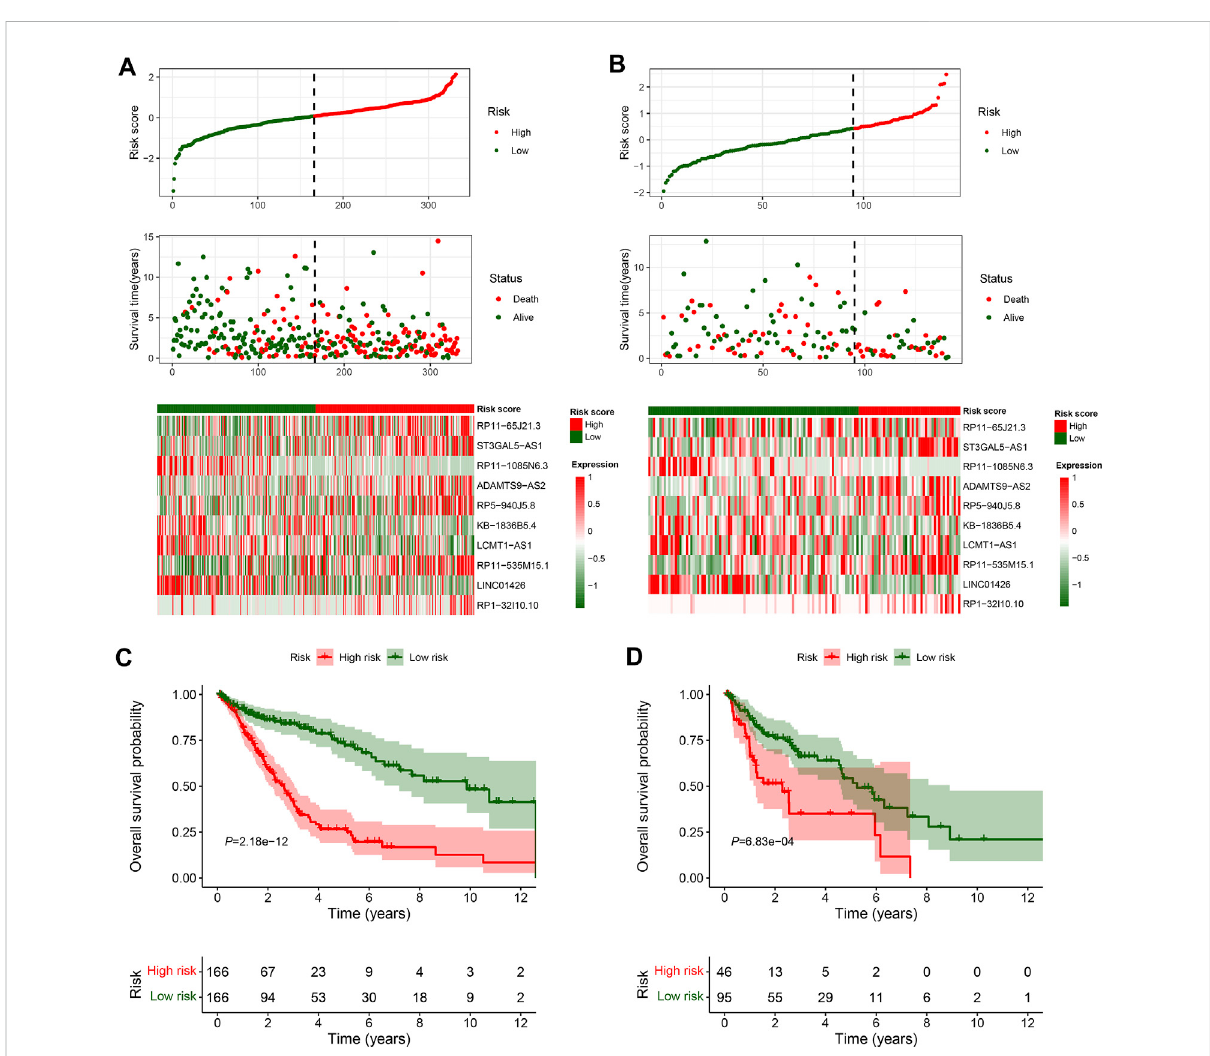
FIGURE 3 Overall survival analysis and validation of the ferroptosis-related lncRNAs signature; (A – B) Distribution of risk score, OS time, OS status and heatmap of the 10 prognostic ferroptosis-related lncRNAs signature in the TCGA-LUSC training set (A) and TCGA-LUSC testing set (B) . (C – D) Kaplan-Meier survival curves of the OS of the patients in the high- and low-risk groups for the TCGA-LUSC training set (C) and TCGA-LUSC testing set (D)